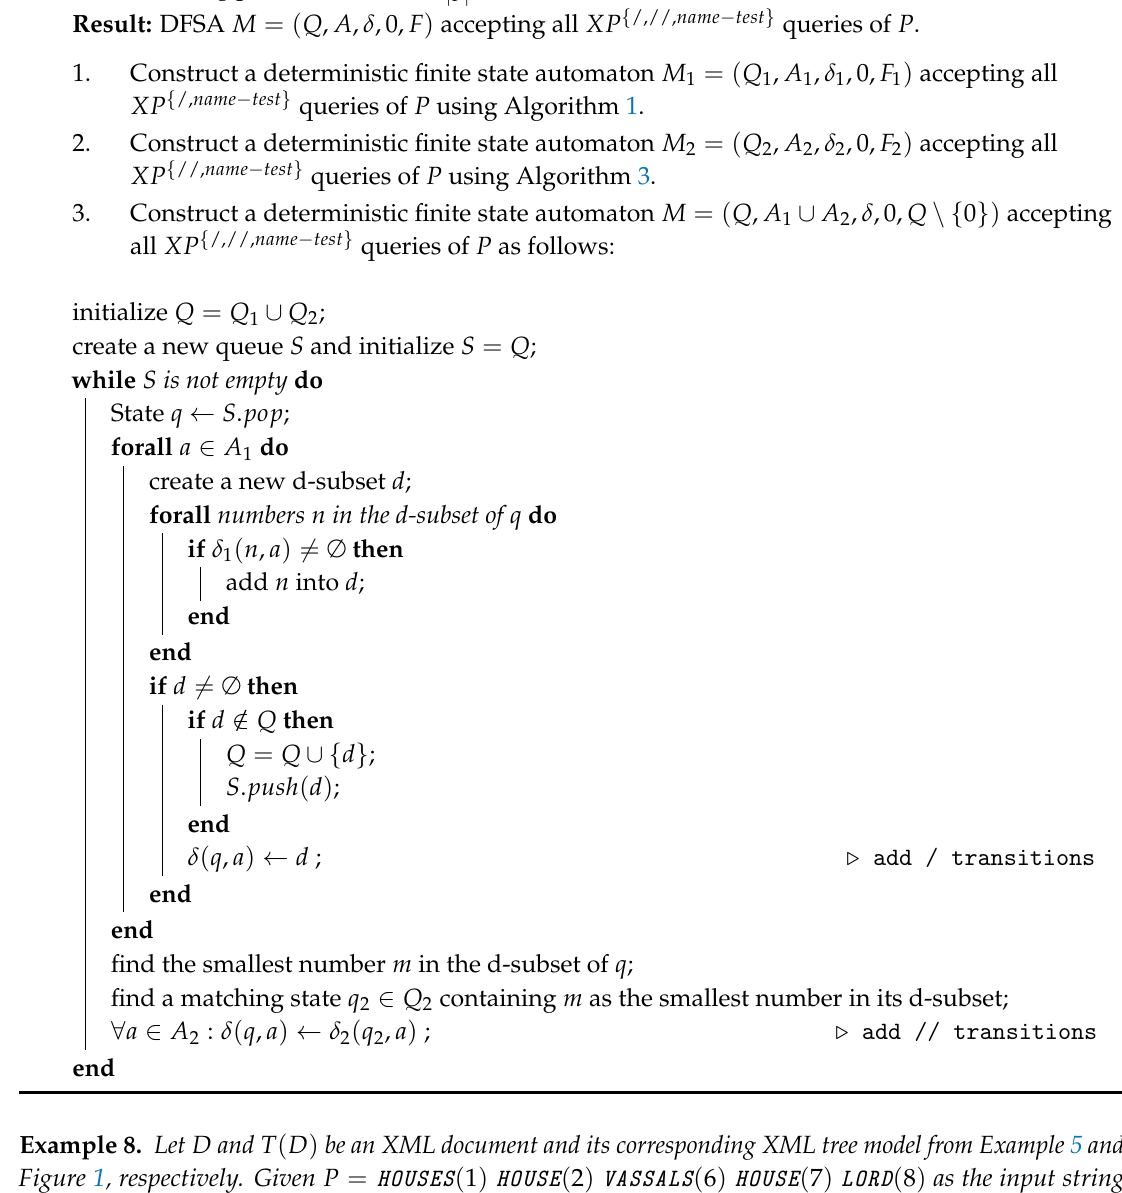
Algorithm 5: Construction of the tree paths automaton for a single string path. Data: A string path P = n 1 n 2 . . . n | P |